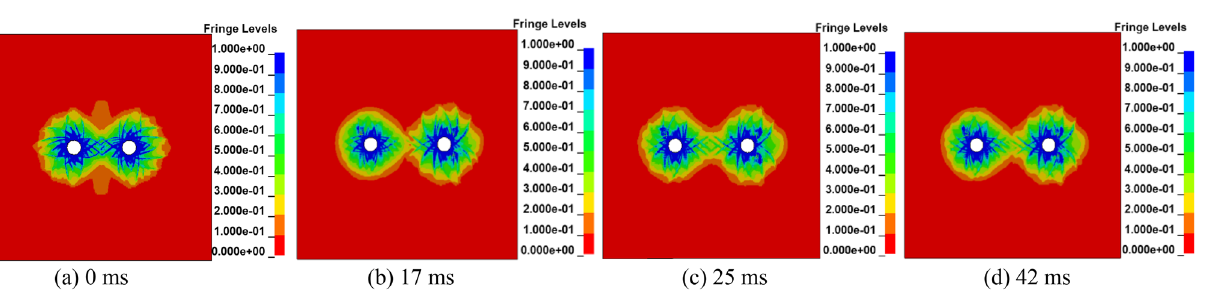
Figure 4. Cloud map of coal damage distribution at different delay